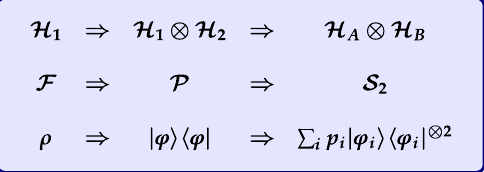
FIG. 1. An illustration of the relations between the feasible region F , the purification P , and the two-party extension S 2 . Here | ϕ (cid:5) is a purification of ρ , H A = H B = H 1 ⊗ H 2 , and | ϕ i (cid:5) are states in P